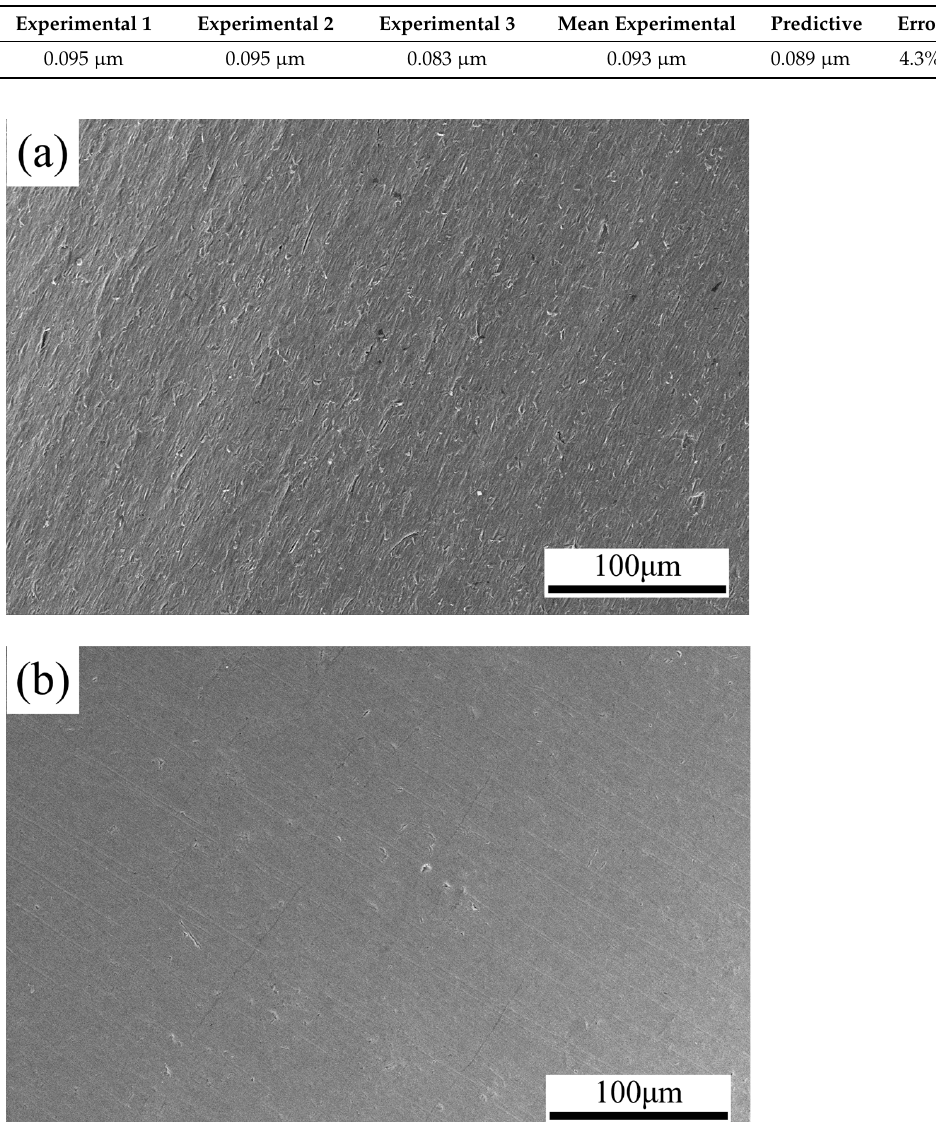
Table 7. Experimental results after parameter optimization.